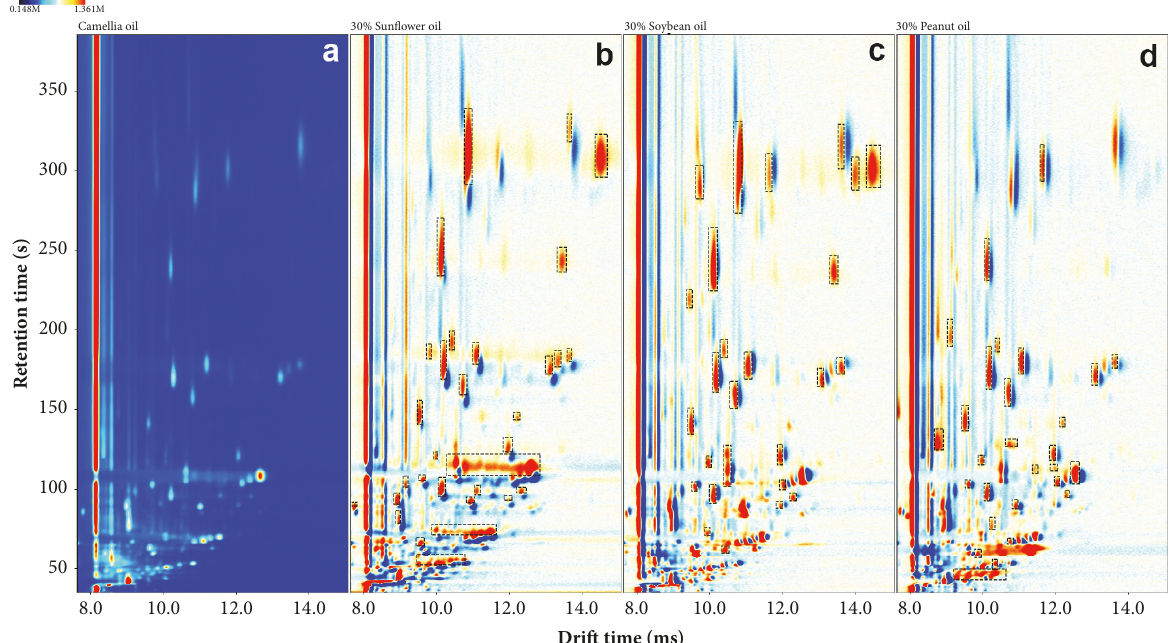
Figure 2: GC-IMS plot comparison of (a) pure canola oil, (b) 30% sunflower oil adulteration, (c) 30% soybean oil adulteration, and (d) 30% peanut oil